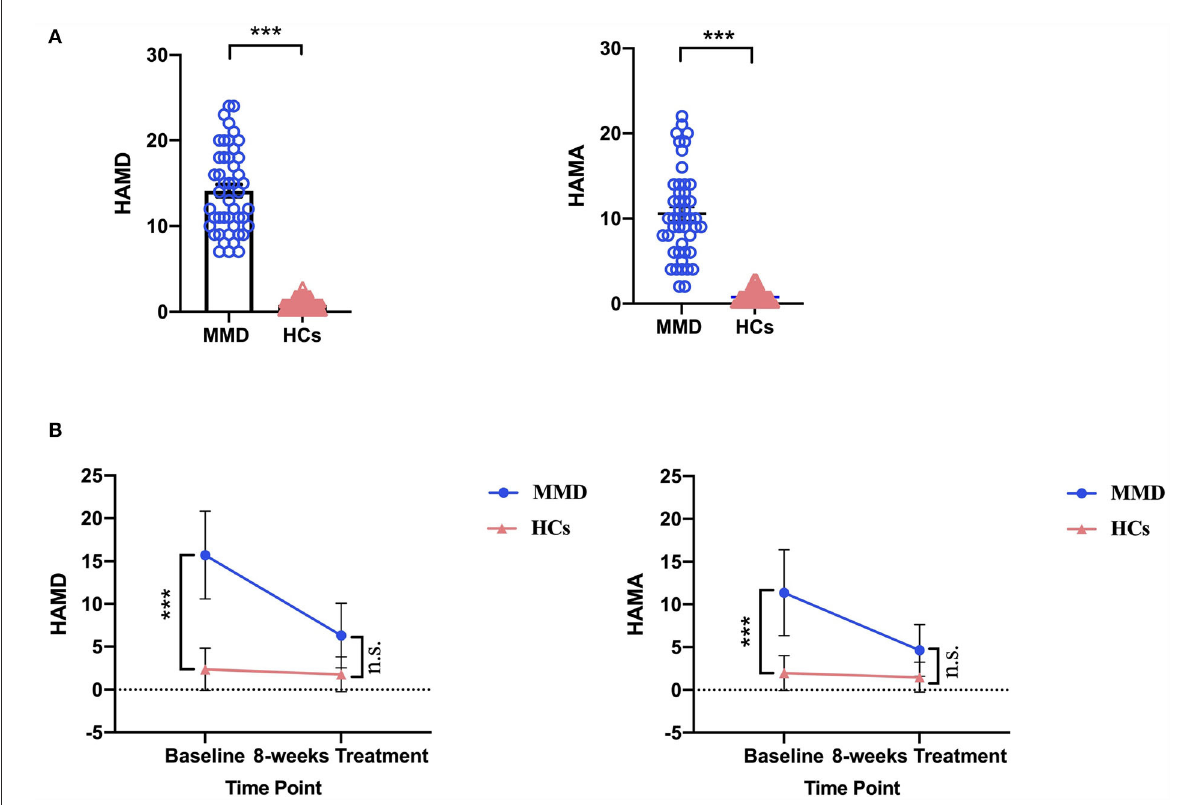
FIGURE1 Comparison of HAMD and HAMA scores between MMD patients and HCs. (A) At the baseline, MMD patients exhibited significantly larger HAMD and HAMA scores than in HCs. The error bars indicate standard error. (B) After 8 weeks SG-treatment, the HAMD and HAMA scores of MMD patients decreased significantly, and there were no significant differences in HAMD and HAMA scores of MMD patients compared HCs. HAMD, hamilton depression; HAMA, hamilton anxiety; MMD, mild-to-moderate depression; HCs, healthy controls. ***, p < 0.001; n.s., no significance.